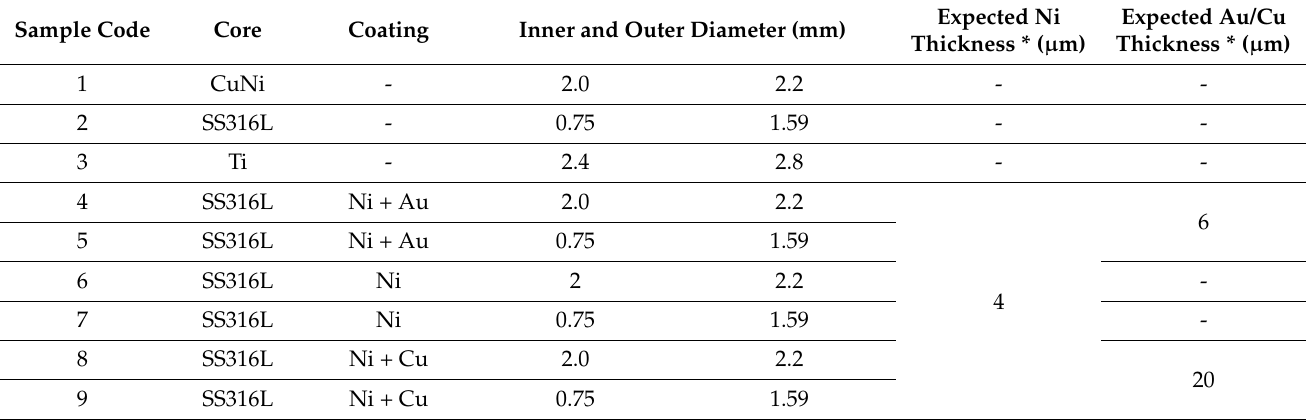
Table 1. List of uncoated and coated samples with sample dimensions.